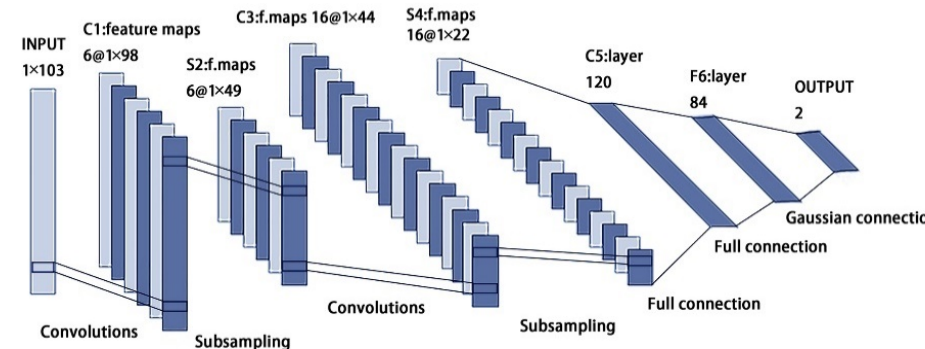
Figure 5. 1D LeNet-5 network model structure.